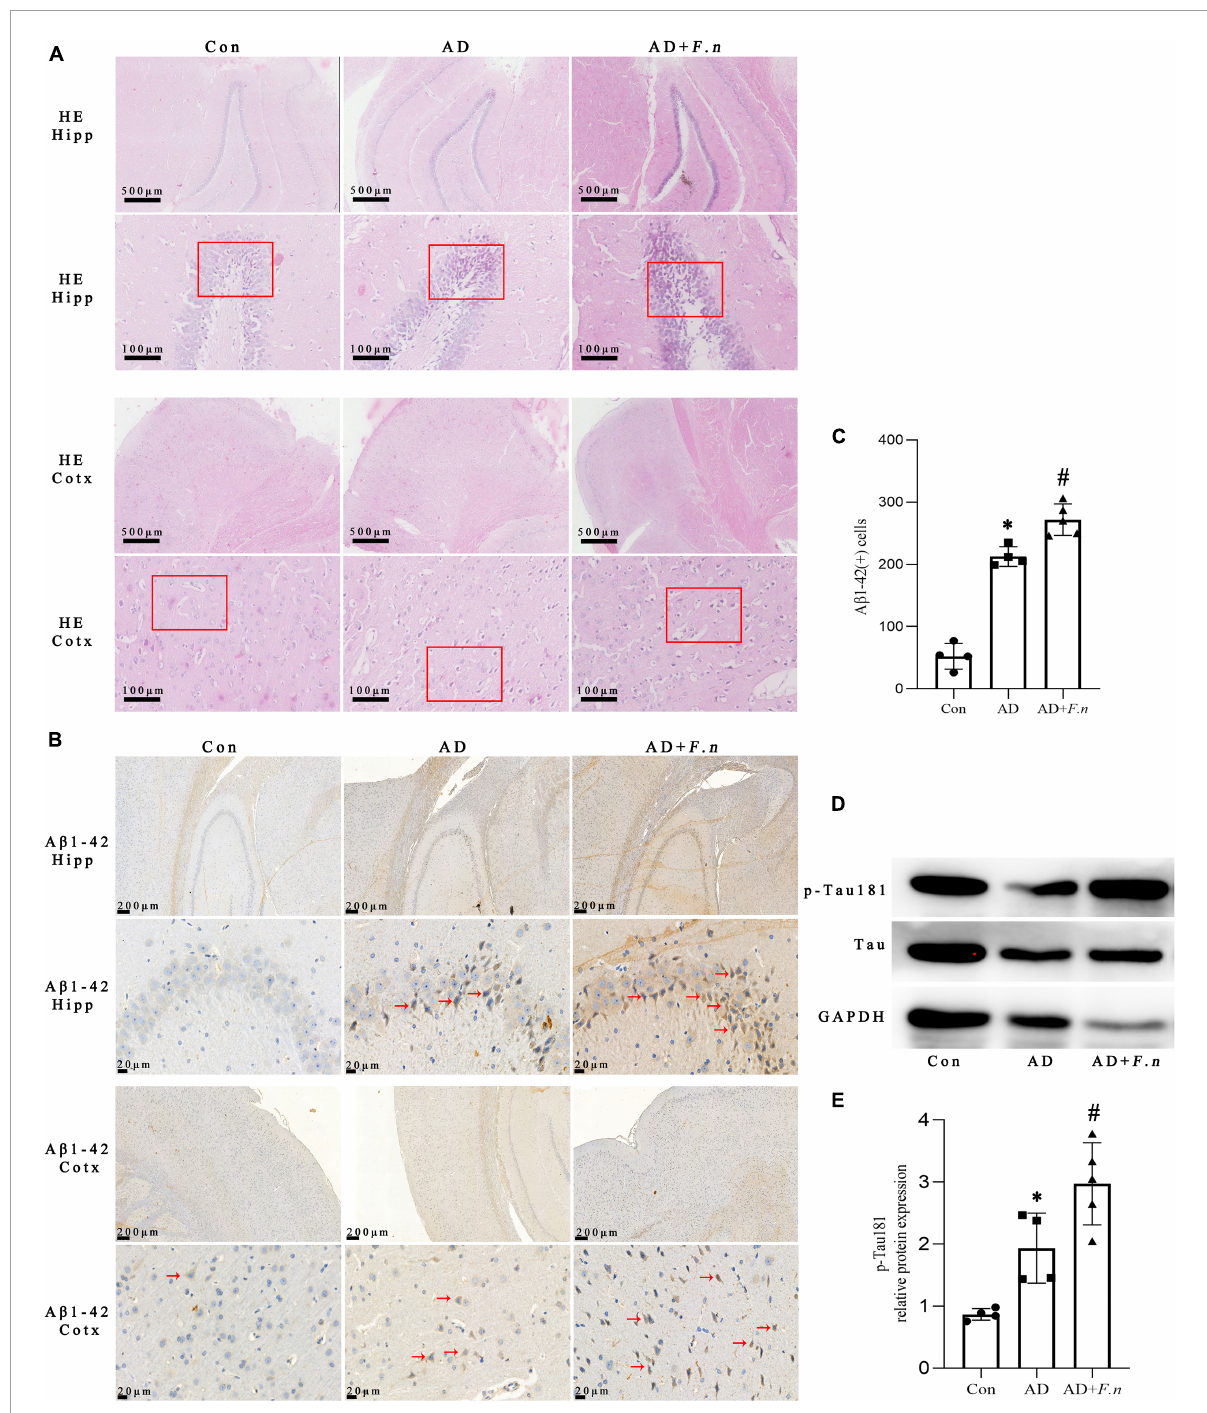
FIGURE3 HE and IHC showed histopathological changes, and WB showed tau hyperphosphorylation in each group. (A) HE showed cell morphology and arrangement. (B) IHC showed the expression of A β 1–42 cells. (C) The number of A β 1–42 cells in the brain. (D) WB showed the expression of p-Tau181 in the brain. (E) Quantitative analysis of the blots. Data presented as mean ± SEM. n = 4–5 in each group, * P < 0.05 vs. Con group, # P < 0.05 vs. AD group, indicates statistically significant